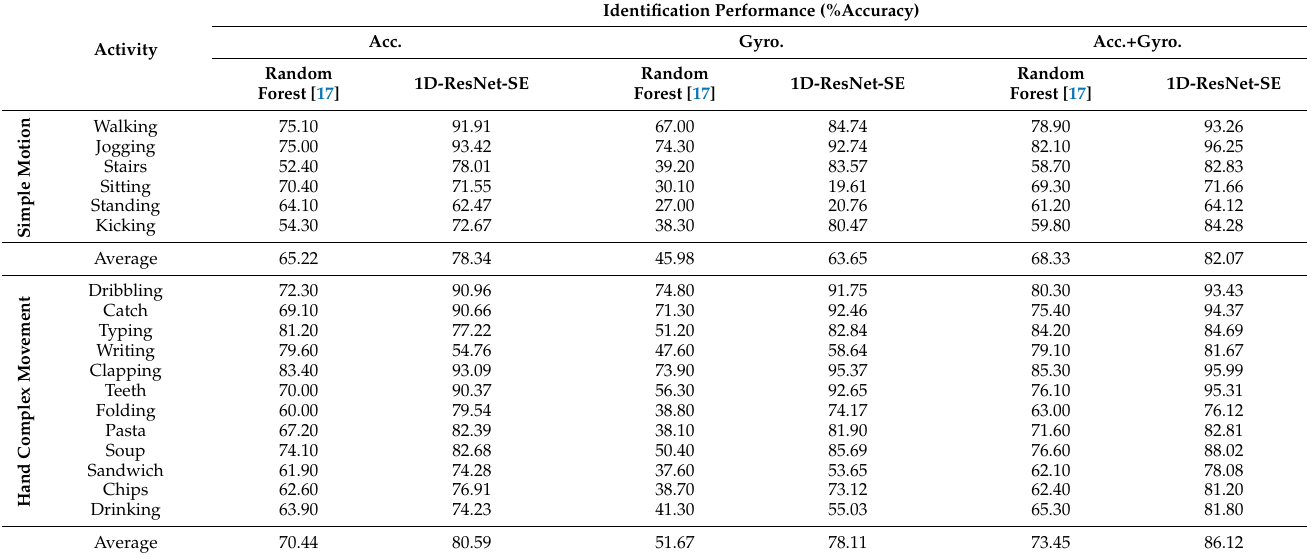
Table 12. The comparison results of the proposed 1D-ResNet-SE model and the previous work